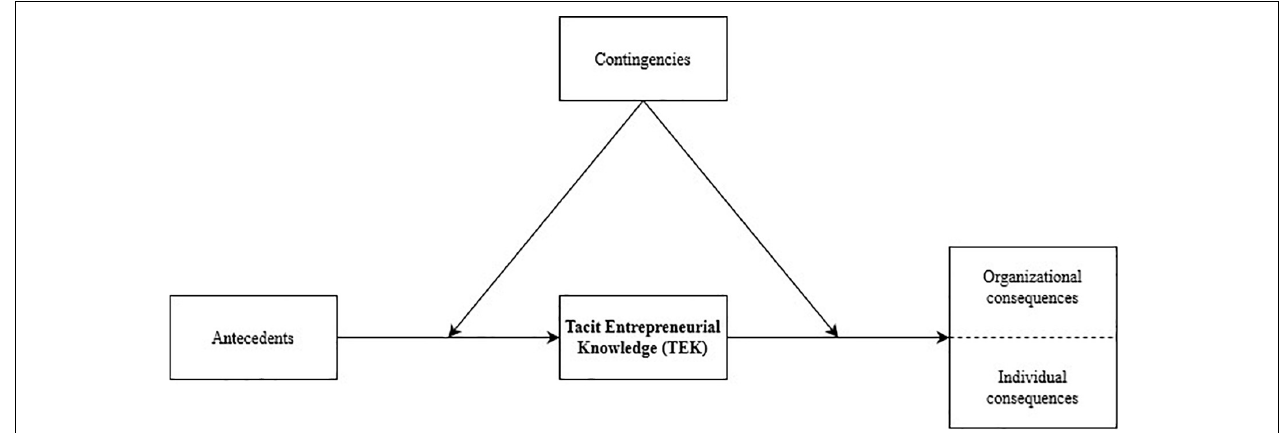
FIGURE 3 | Antecedent-consequence model of Tacit Entrepreneurial Knowledge